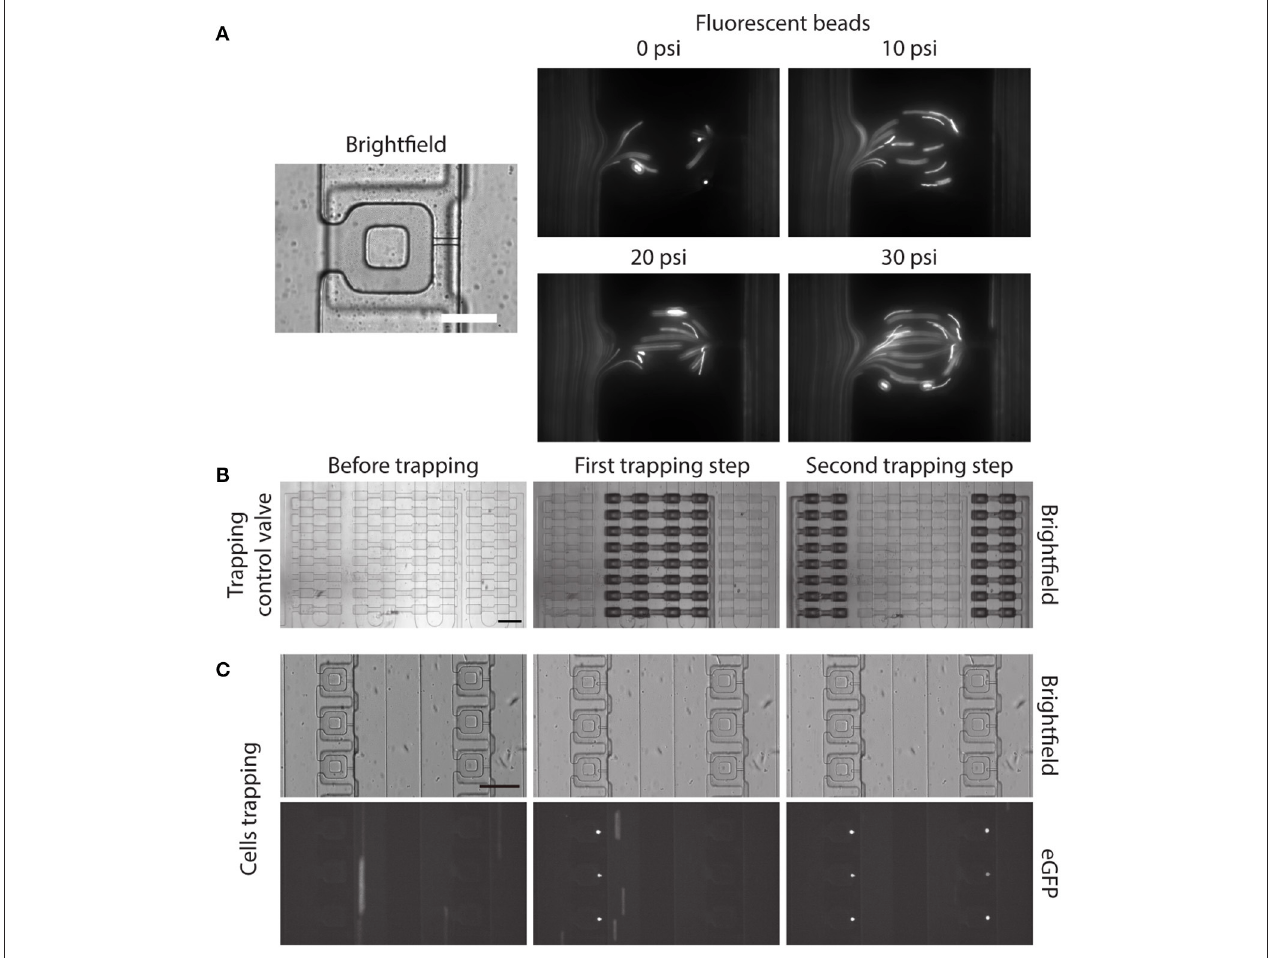
FIGURE 4 | Two-step, pneumatically controlled cell trapping. (A) Brightfield image of the compression chamber and fluorescence images of the 1 µ m Y (yellow)-G (green) fluorescent beads when the trapping control valve was pressurized at different pressures. Scale bar = 60 µ m. (B,C) Brightfield images of the compression chamber (B) and fluorescence images of the trapped eGFP expressing MCF-10A cells (C) when the trapping control valve was changed from before trapping ( C , left) to after first trapping step ( C , middle) and second trapping step ( C , right). Scale bar = 200 µ